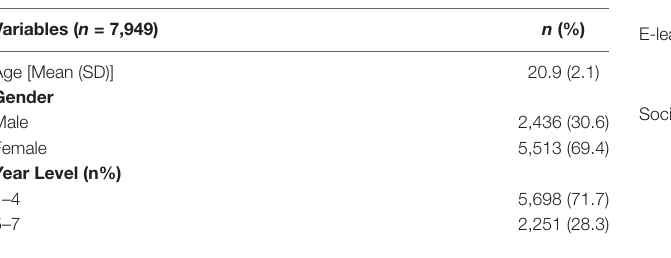
TABLE 1 | Student characteristics.